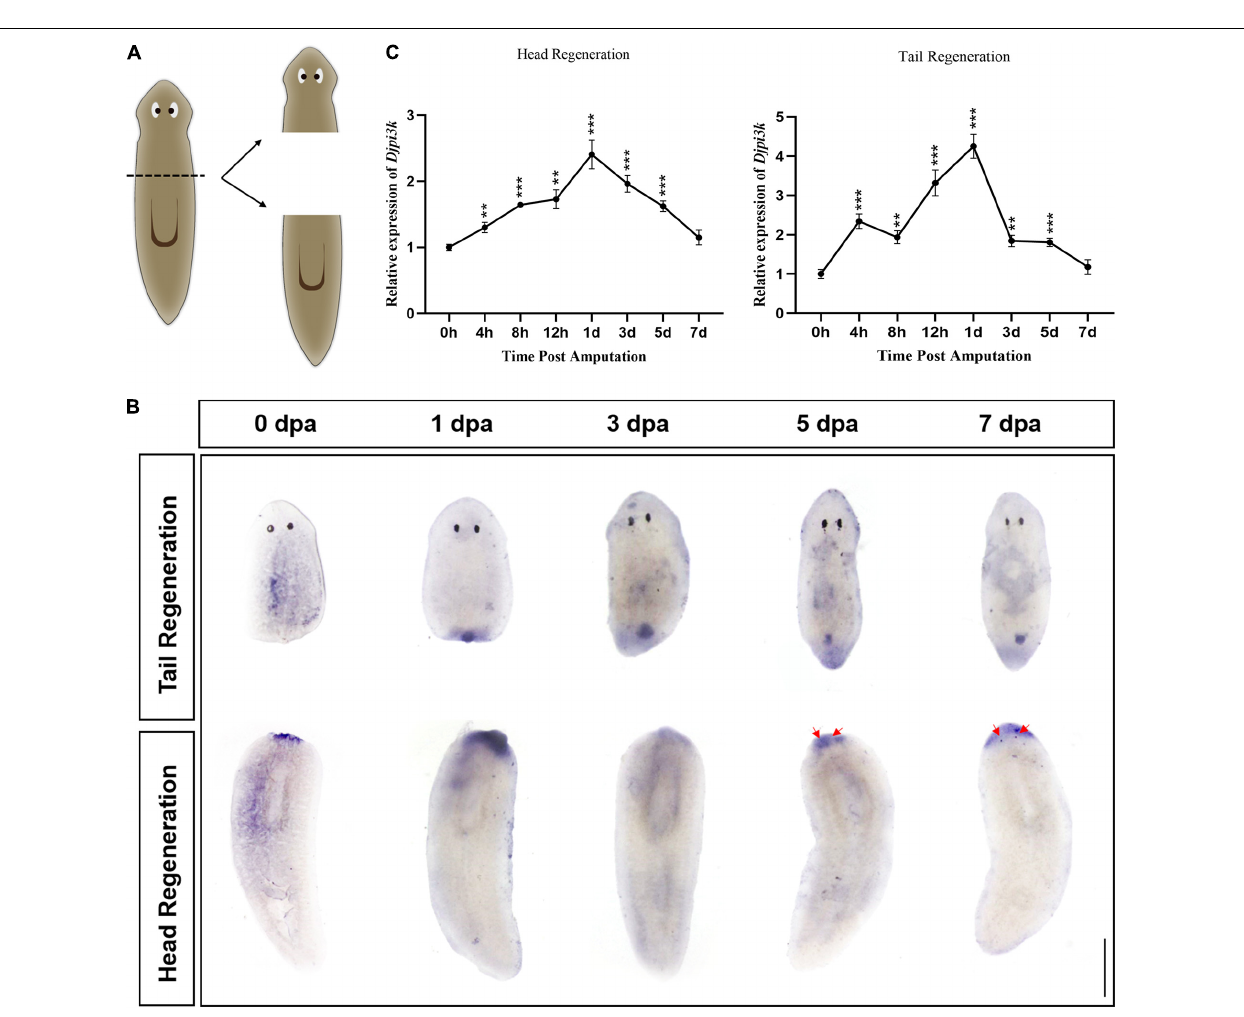
FIGURE 2 | Expression pattern of Djpi3k during planarian regeneration. (A) Schematic representation of the general sampling set-up. (B) Spatiotemporal expression pattern of Djpi3k during planarian regeneration assessed by whole-mount in situ hybridization. Newly-regenerated photoreceptors are indicated with red arrows. Scale bar = 1 mm. (C) Fold change in mRNA expression levels of Djpi3k during planarian head and tail regeneration. All values are relative to the expression level of Djpi3k mRNA at 0 h. ** P < 0.01 and *** P < 0.001, by the Student’s t